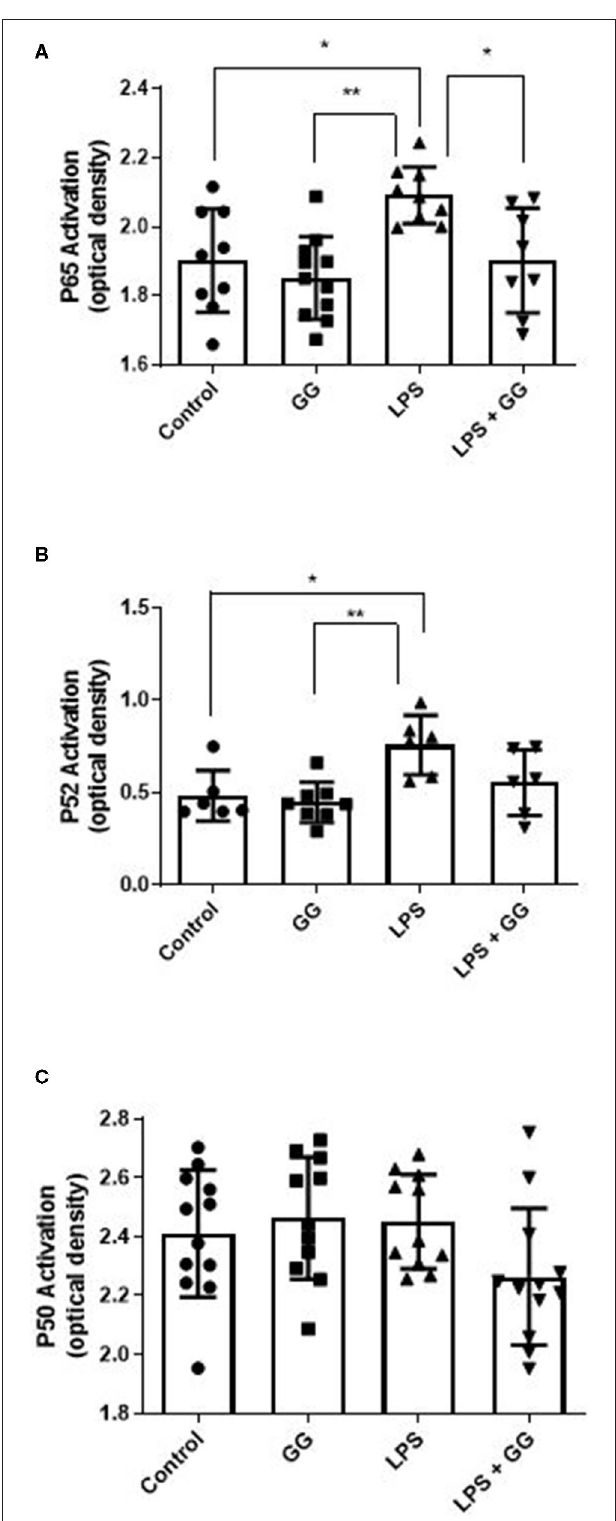
FIGURE 5 | Ganglioside inhibits LPS-stimulated activation of NF- κ B P65 and P52 subunits. CaCo-2 cells were incubated with ganglioside (10 µ g/ml) for